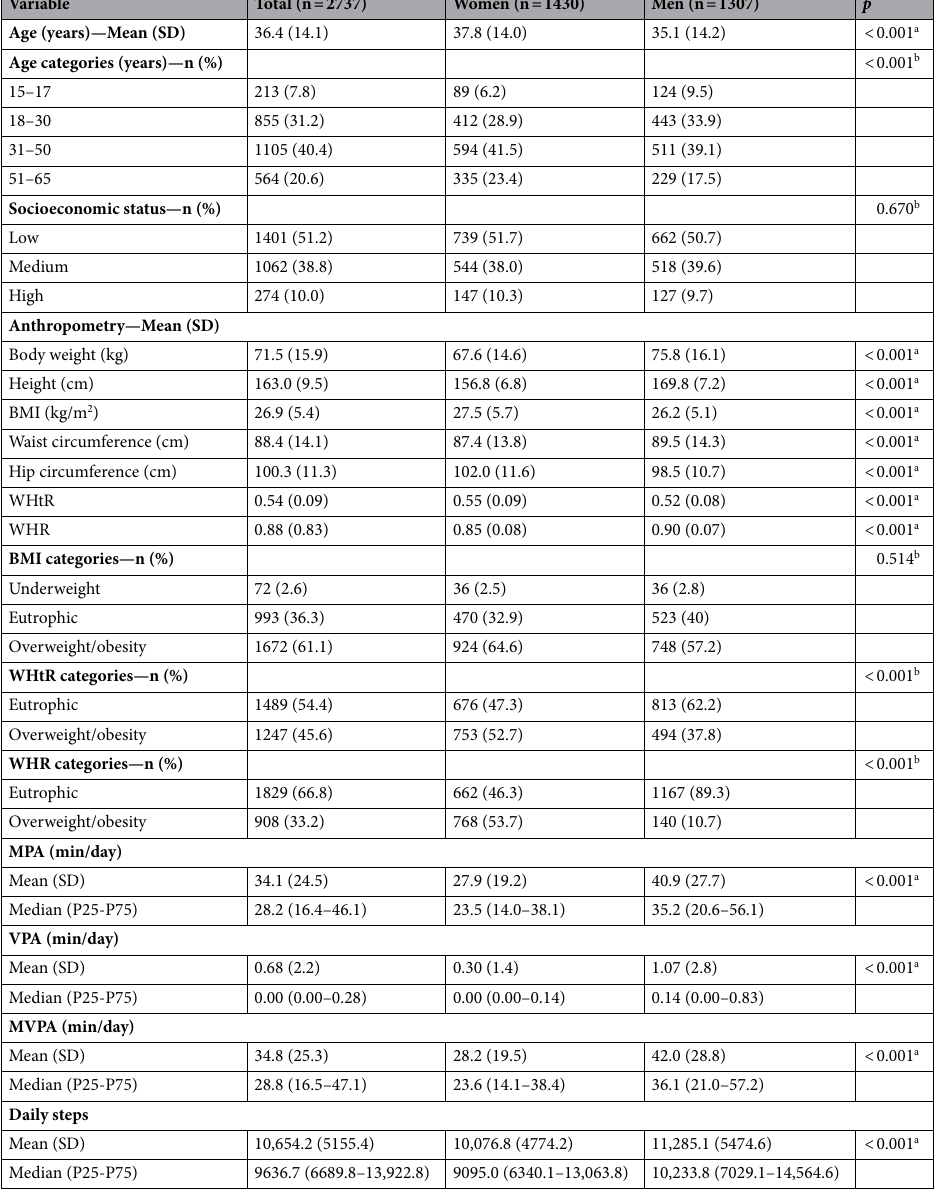
Table 1. Descriptive analysis for sociodemographic variables, anthropometric measurements and physical activity according to sex. BMI, body mass index; WHtR, waist-to-height ratio; WHR, waist-hip ratio; MPA, moderate physical activity; VPA, vigorous physical activity; MVPA, moderate-to-vigorous physical activity. a Significance value of t-student for independent samples. b Chi-square test significance